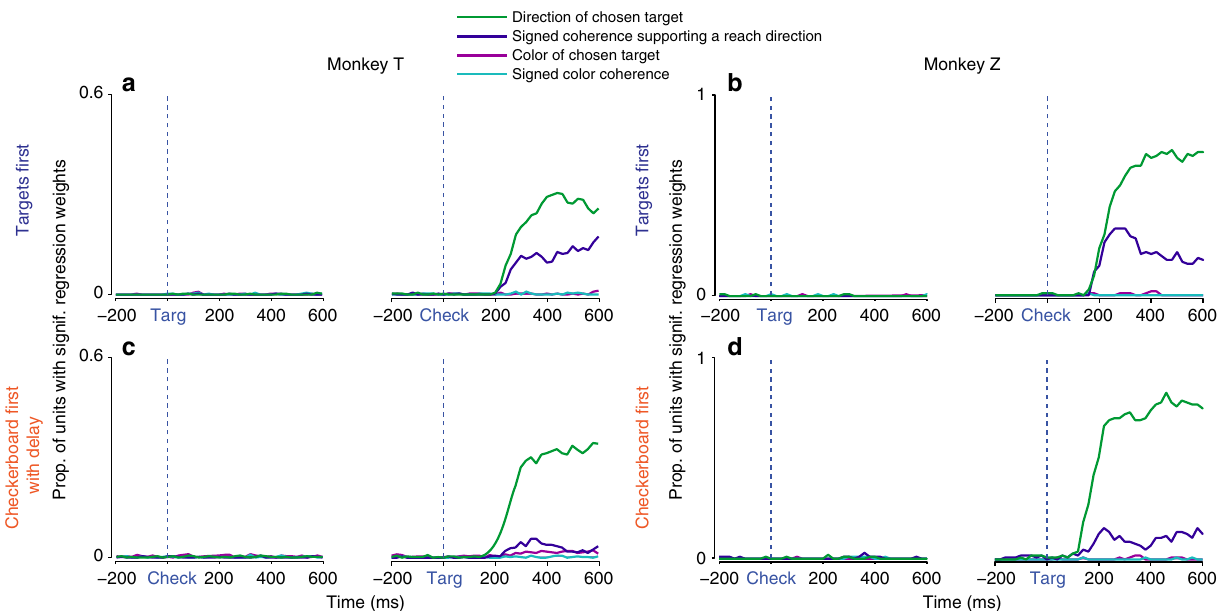
Fig. 5 PMd activity re fl ected action decisions, not perceptual decisions. Each unit ’ s fi ring rate at a given 20 ms time point across trials was regressed on a linear model with the following predictor variables: direction of the chosen target (green), signed checkerboard coherence favoring a particular reach direction independent of its color (dark blue), color of the chosen target independent of its direction (magenta), and signed checkerboard color coherence independent of the direction of the chosen target (turquoise). This regression analysis was repeated for all units and all time points from − 200 ms before to + 600 ms after the appearance of the fi rst visual cue in each trial (left of sub fi gure) and of the second visual cue (right). Plotted are the proportions of units with signi fi cant regression weights for a given predictor at each 20 ms time point, for each monkey (columns) and task (rows). Very few signi fi cant correlations with any regression predictor were seen during the observation period of the fi rst visual cue (left panel of each pair) in either TF ( a , b ) or CF/CFD ( c , d ). In particular, signi fi cant correlations with chosen target color (magenta) and signed checkerboard color coherence (turquoise) rarely occurred at any time in either task in either monkey. However, following the second visual cue, there were signi fi cant correlations with the direction of the chosen target (green) and the signed level of checkerboard evidence favoring a target direction independent of its color (dark blue). Correlates with the direction of chosen target (green) were comparably frequent across both tasks for each monkey, with more units exhibiting selectivity in Z because the targets were placed in each unit ’ s preferred and non-preferred directions. The incidence of signi fi cant correlations with signed checkerboard evidence favoring a particular reach direction (dark blue) was present, but substantially lower, in both monkeys in the CF/CFD tasks compared to in the TF